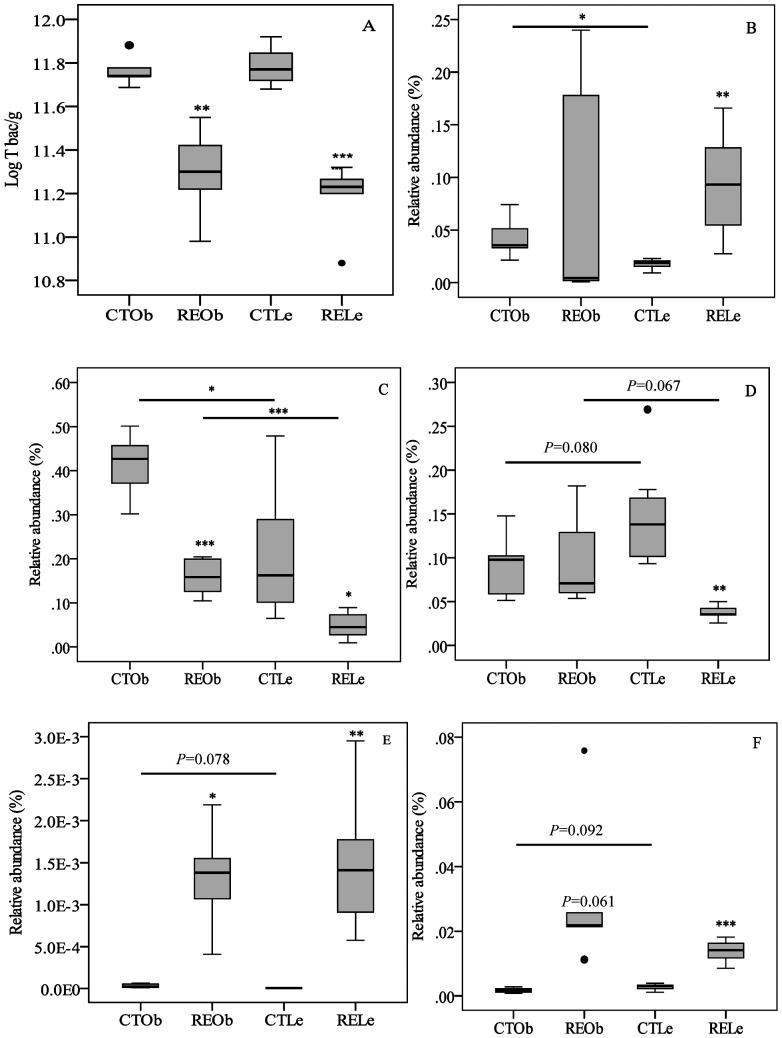
Box-and-Whisker plots of the content of bacteria in the caecum of obese (Ob) and lean (Le) female Zucker rats fed a control diet (CT) or the diet supplemented with a rosemary extract (RE) enriched in CA (40%).Caecum content of: A) Total bacteria (T bac) indicated as log10 of the value per gram of caecum content (fresh weight), B) Bifidobacterium genus, C) Lactobacillus/Leuconostoc/Pediococcus group, D) Clostridium leptum group, E) Blautia coccoides group and F) Bacteroides-Prevotella group. Results for each group are presented as relative abundance (%) of total bacteria. Horizontal lines represent the comparison between obese and lean rats. Significant differences are indicated by *P<0.05, **P<0.01, ***P<0.001. P values below 0.1are also displayed as indication of a trend.